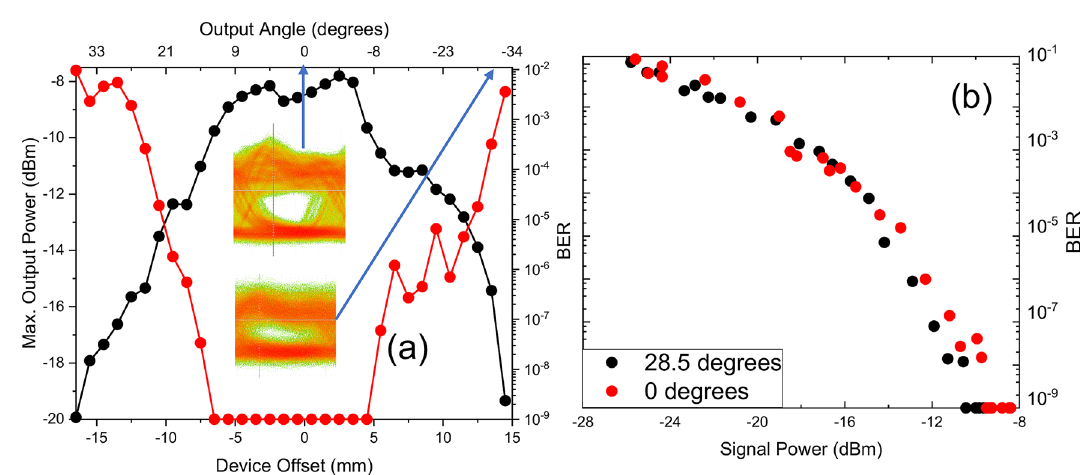
Figure 5. ( a ) Received power (black dots) and BER (red dots) corresponding to that power, as a function of device offset and output angle. (inset: eye diagrams at 0 mm and 14 mm device offset) ( b ) BER as a function of received signal power for two different input angles. The BER tester used in these measurements saturates at 10 –9